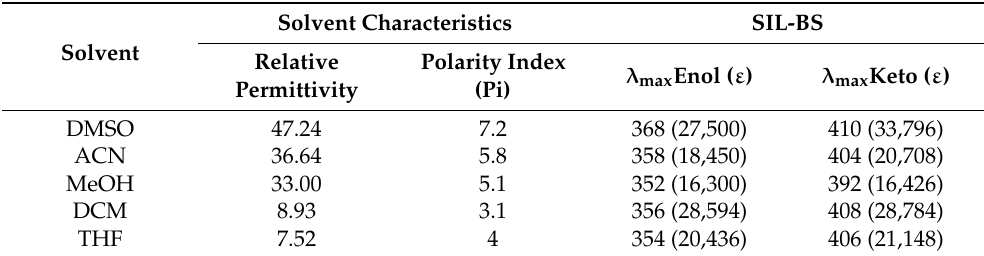
Table 1. Spectral characteristics of SIL-BS in solvents with different